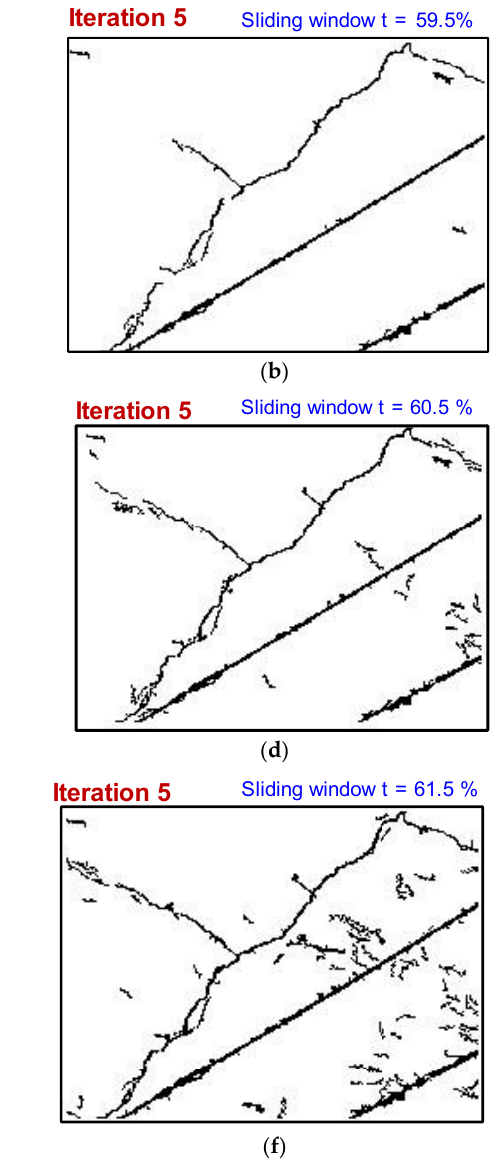
Figure 8. Effect of initial threshold percentage on tracking thin shallow cracks ( a ) t = 57 %, ( c ) t = 58 %, ( e ) t = 59 %. ( b , d , f ) Tracking missing thin crack segments after 5 th iteration for corre- sponding pixelated residue with an initial threshold sensitivity parameters as shown in ( a , c , e ). Note: ∆ t for each iteration is 0.5 %. Table 1. Computational time comparison between the proposed framework and existing DL